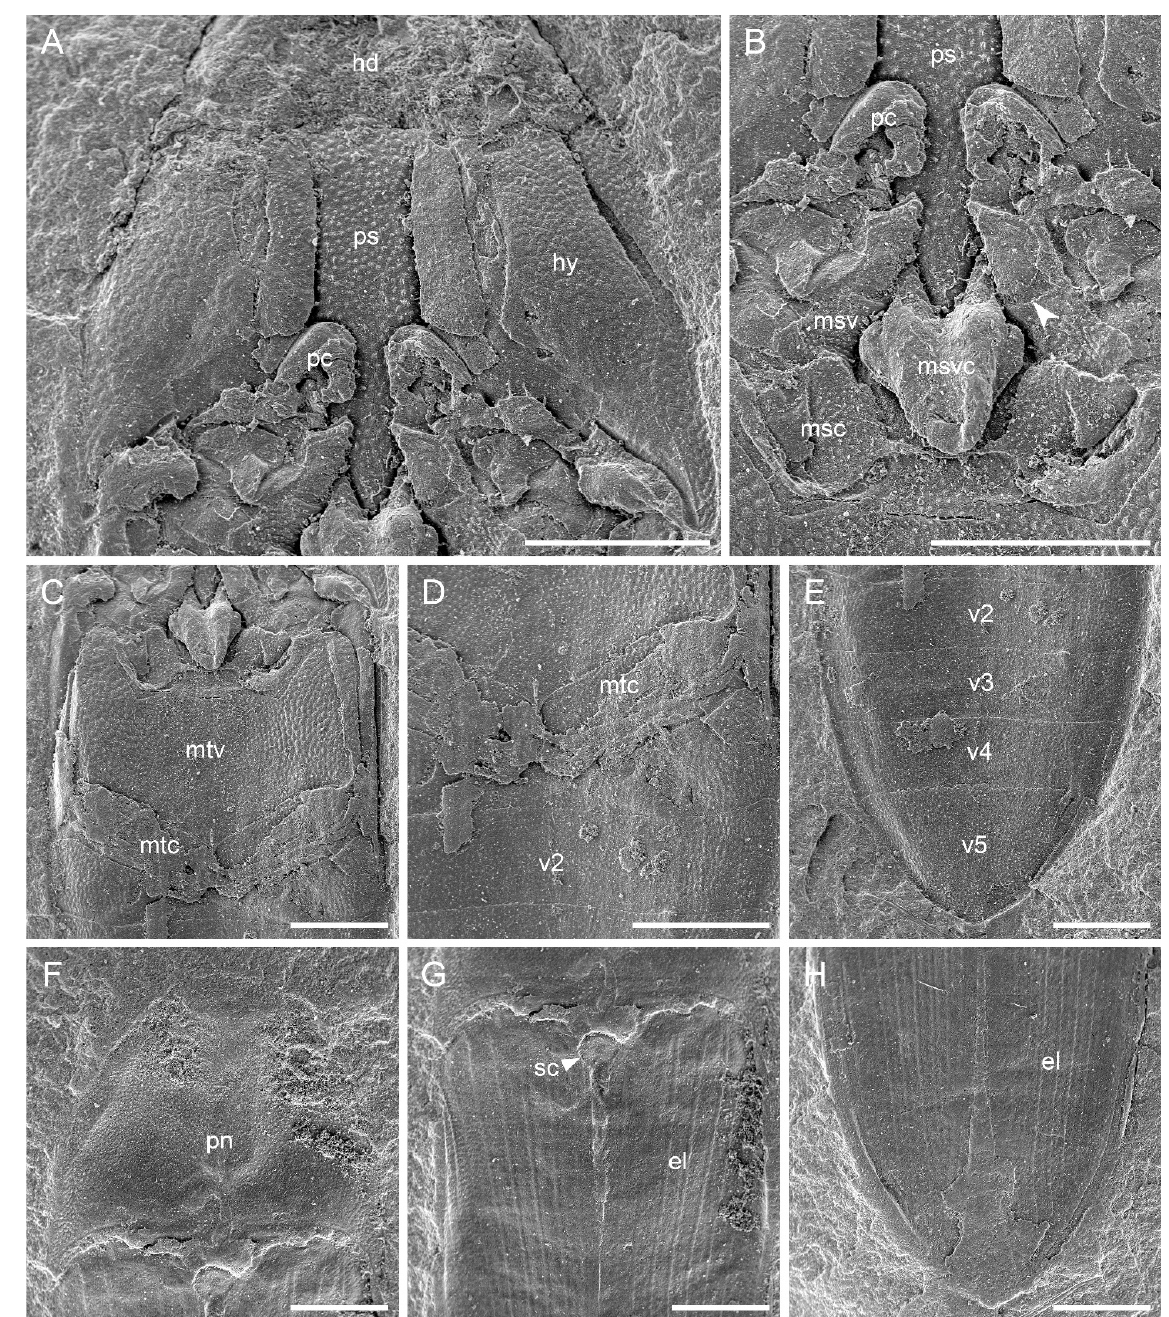
Figure 2. Details of Archaeolus funestus Lin, 1986, holotype, NIGP70071, under scanning electron microscopy (SEM). ( A–E ) NIGP70071b. ( A ) Head and prothorax. ( B ) Mesothorax, showing the line between mesoventrite body and procoxal rests (arrowhead). ( C ) Metathorax. ( D ) Metacoxae and abdominal base. ( E ) Abdominal apex. ( F – H ) NIGP70071a. ( F ) Prothorax. ( G ) Elytral base. ( H ) Elytral apex. Abbreviations: el, elytron; hd, head; hy, hypomeron (pronotum); msc, mesocoxa; msv, mesoventrite; msvc, mesoventral cavity; mtc, metacoxa; mtv, metaventrite; pc, procoxa; pn, pronotum; ps, prosternum; sc, scutellum; v2–5, ventrites 2–5. Scale bars: 400 μ m.